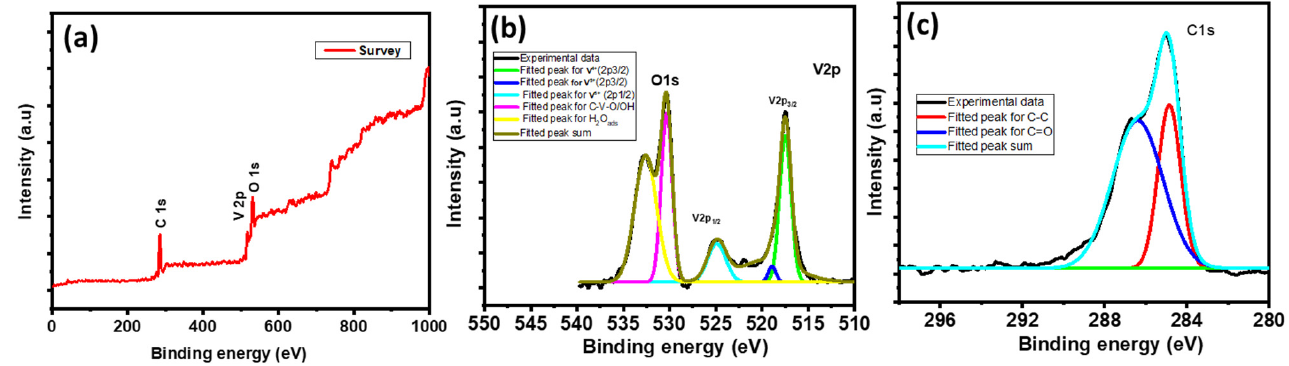
Figure 3. XPS spectra of V 2 O 5 /RGO composite, ( a ) a survey scan spectrum, ( b ) O1s and V2p spectra and ( c ) a C1s spectrum.